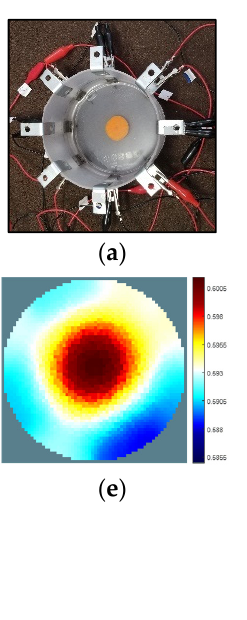
0.71 to 0.9 S/m with the decrease in the hyperparameter value. S/m) of the domain because the maximum current passes through the side wall.